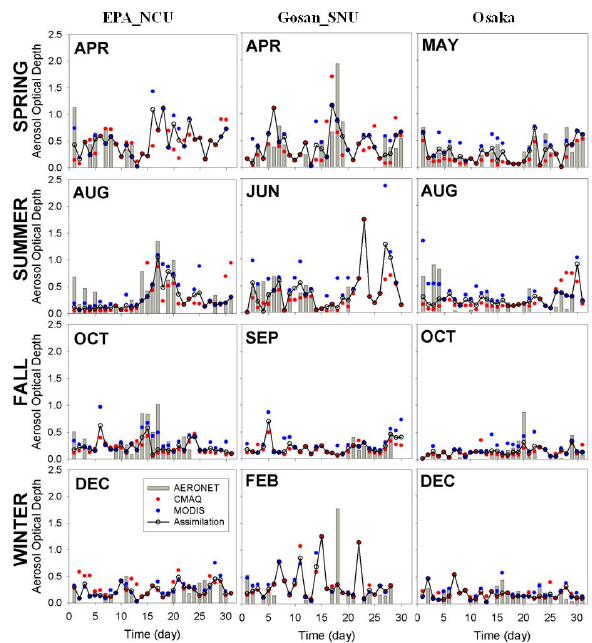
Fig. 12. Daily variations in the MODIS-retrieved, CMAQ- simulated, assimilated and AERONET AODs at the 3 AERONET sites in East Asia for all four seasons, 2006. Grey bars, blue cir- cles, red circles and black solid lines represent AODs obtained from AERONET, MODIS, CMAQ and assimilation,